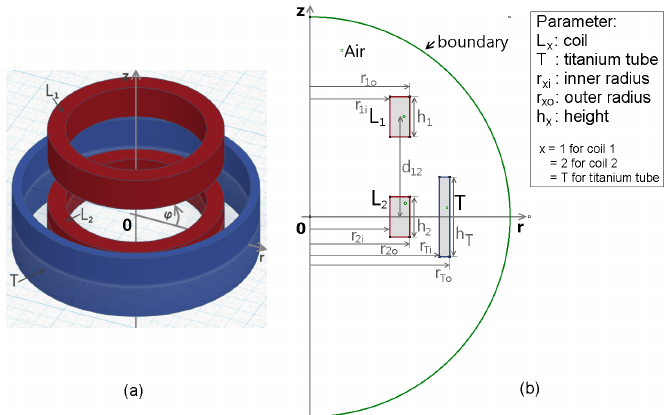
Figure 1. FEM model of an axially symmetric magnetic problem setup, with two coils, L 1 and L 2 (red) and a titanium tube T around L 2 (blue). ( a ) shows the three-dimensional model of the setup in a polar coordinate system where z is the symmetry axis; ( b ) shows the the setup in FEMM, where the green semicircle is the boundary region and the legend describes the used